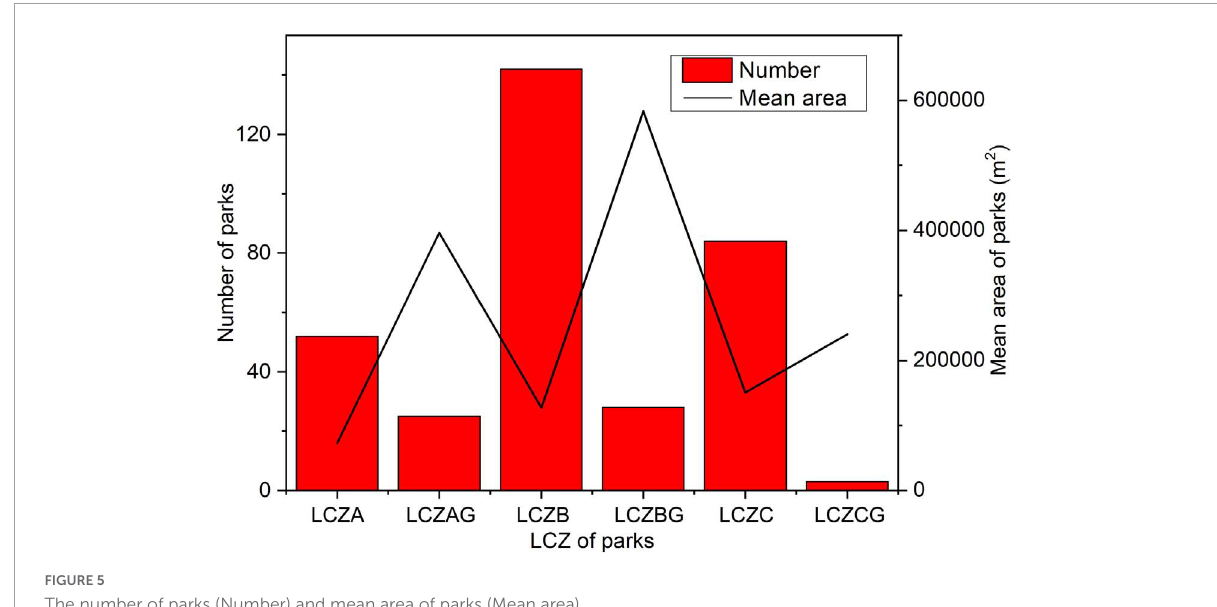
FIGURE5 The number of parks (Number) and mean area of parks (Mean area).